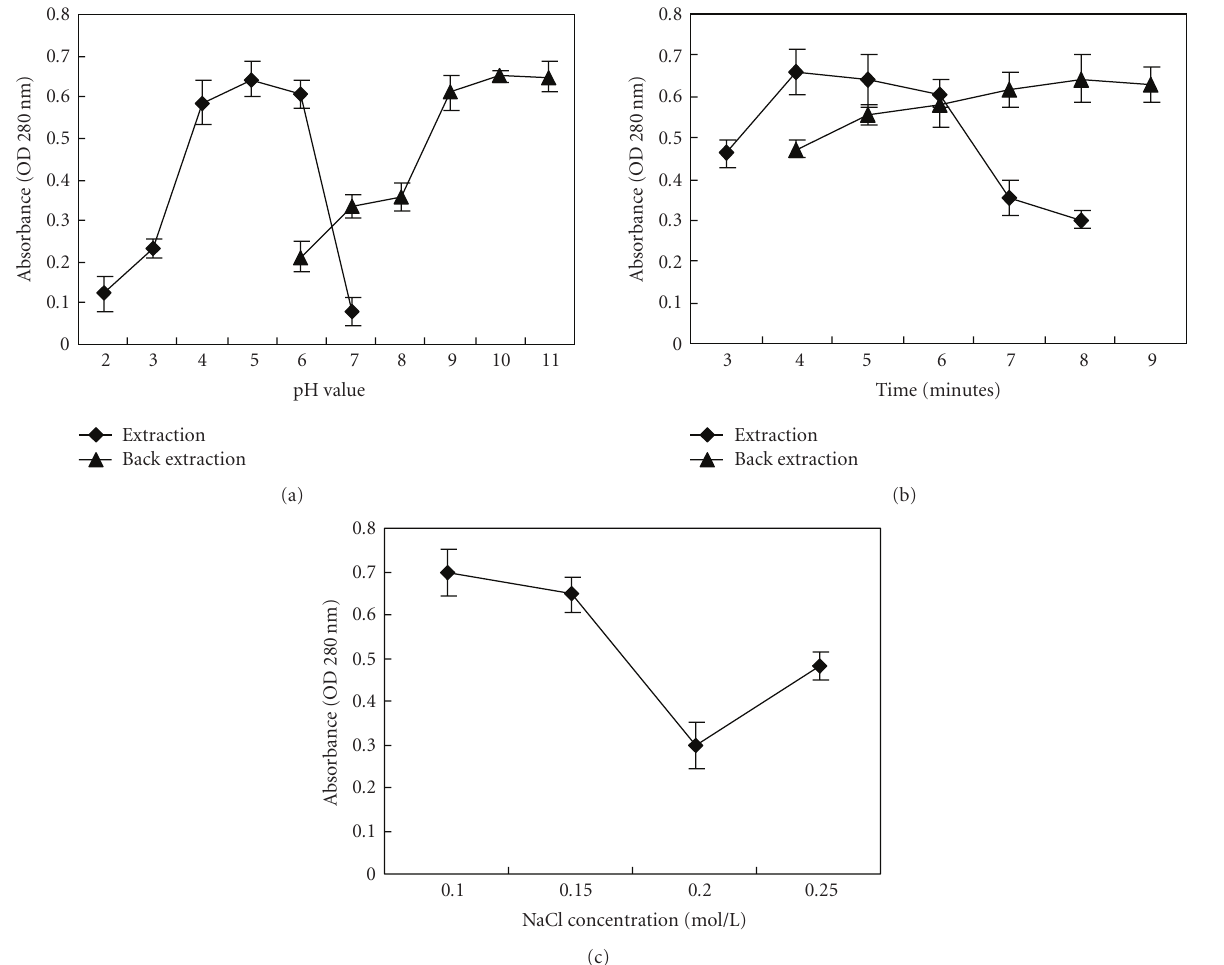
Figure 1: E ff ect of pH (a), extraction time (b), and ion strength (c) on reversed micelle extraction of red kidney bean lectin. Data represent means ± SD ( n = 6). Table 1: Protein concentration and hemagglutinating activity of each extract. Data represent means ± SD ( n = 4). Parameter Traditional method Reversed micelle extraction Soak Degreasing Homogenizing Degreased Undegreased Total protein (mg) Extraction rate (%) Specific activity